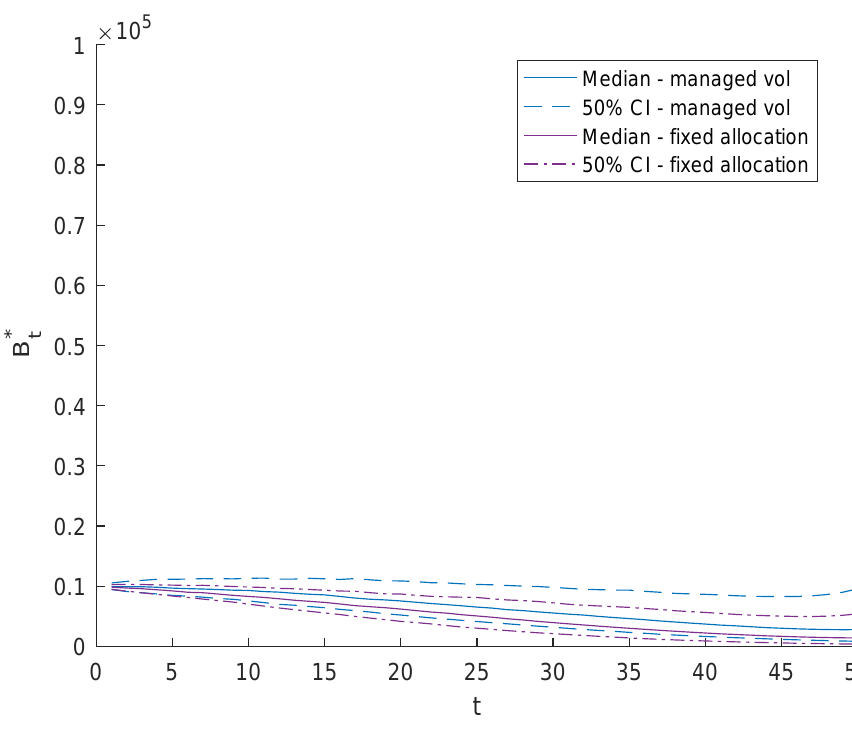
Figure 4. The 50% confidence interval of annuity payments. Managed-Volatility vs. Fixed Allocation